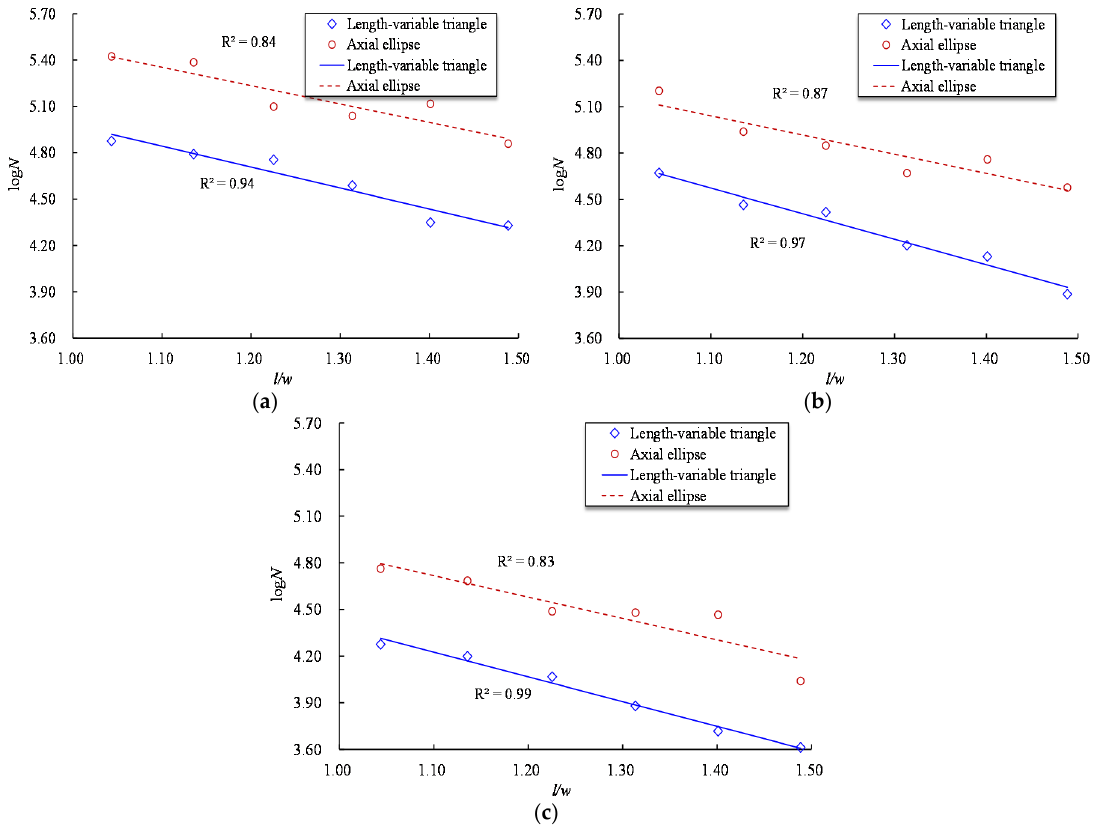
Figure 10. Relationship between fatigue life and l / w of length-variable triangular and axial elliptical shaped notches at three stress levels. ( a ) 0.4 R m ; ( b ) 0.5 R m ; ( c ) 0.6 R m .